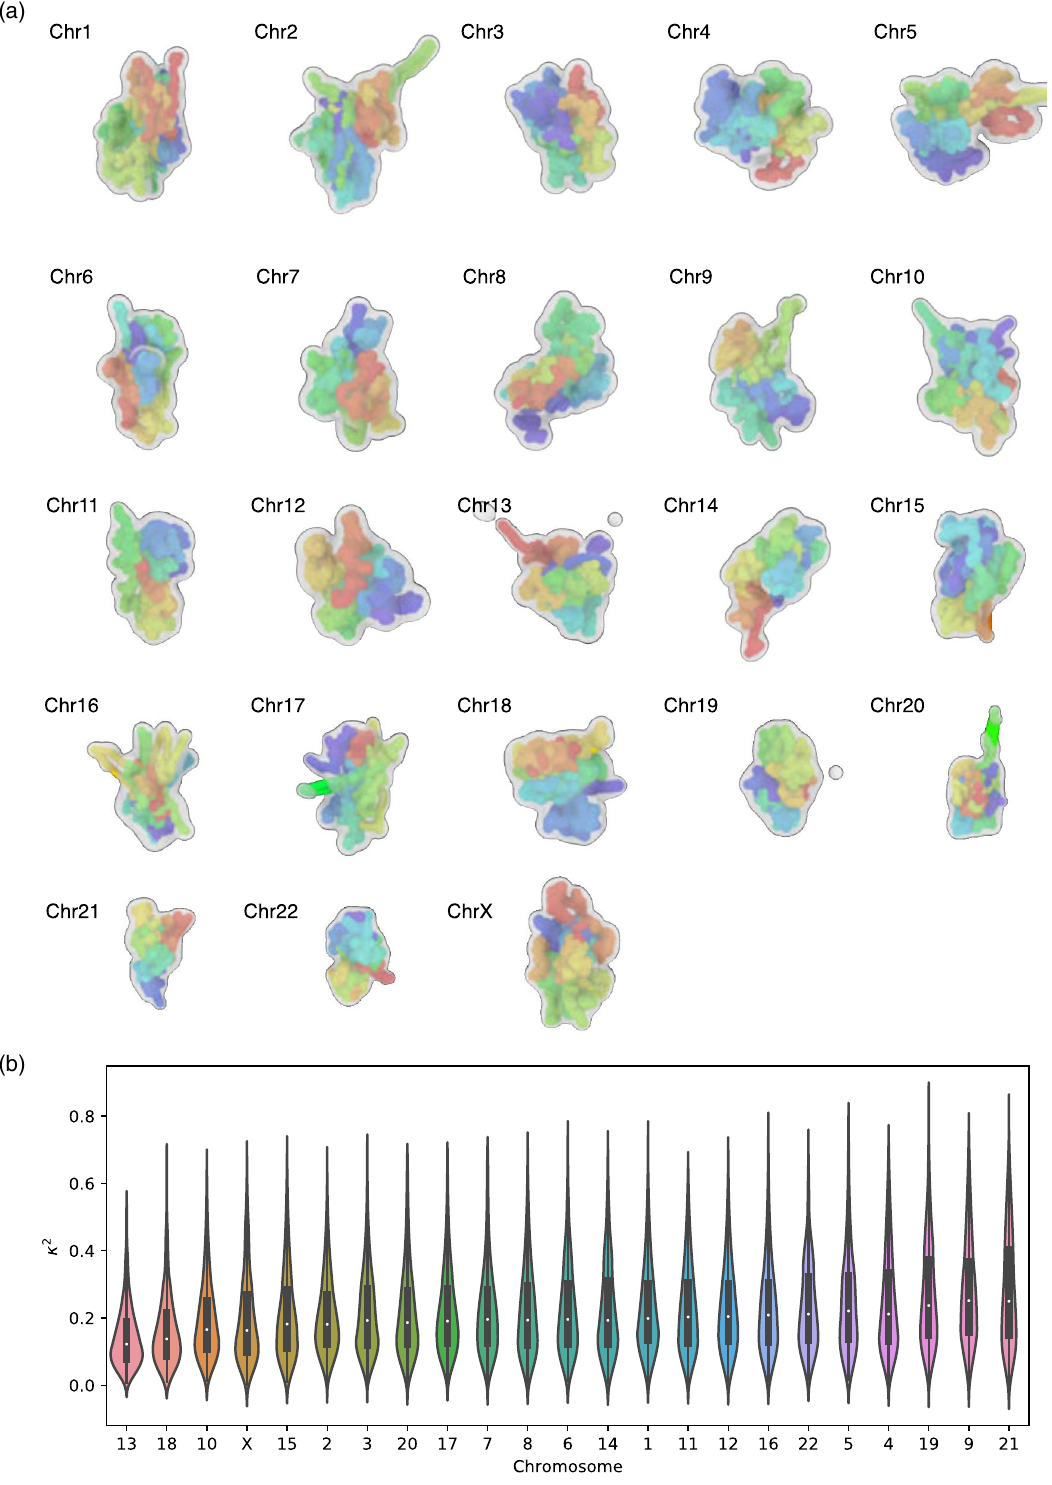
FIG. 4. (a) Representative 3D reconstructed structures for all the 23 human interphase chromosomes using the inferred distance matrices, which are calculated using Eq. (7) with Λ ¼ 117 nm and α ¼ 4 . 0 . The colors encode the genomic position of the loci. The resolution of loci is 100 kbps. Red and purple represent the 5 0 and 3 0 ends, respectively. The structures with radii of gyration that are close to the population average are selected. The structures are rendered using bond radius, Λ ¼ 117 nm. More individual conformations are shown in Fig. 16. (b) Violin plot for the relative shape anisotropy κ 2 (Appendix G) for all the 23 chromosomes. The chromosomes are ordered with increasing of h κ 2 i